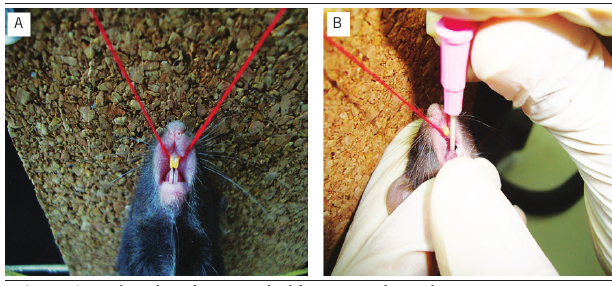
Figure 2 − Adapted intubation method from Hamacher et al . A) anesthetized mouse in the vertical position on the platform; B) handling the cannula during the murine intubation